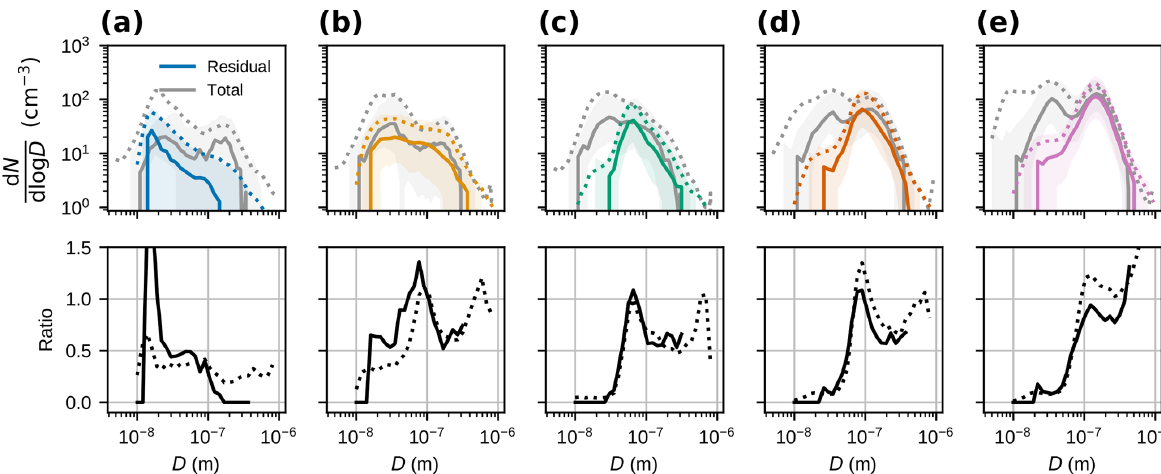
Figure 11. Size distributions and activation ratios for the clusters from Fig. 8. The top row shows cloud residual size distributions (in colour) and the corresponding total particle size distributions (grey). Solid and dotted lines show median and mean values, respectively, and shaded areas indicate the 25th to 75th percentile ranges. The bottom row shows activation ratios calculated from the median (solid) and mean (dotted) distributions. Columns (a–e) show clusters 1–5,